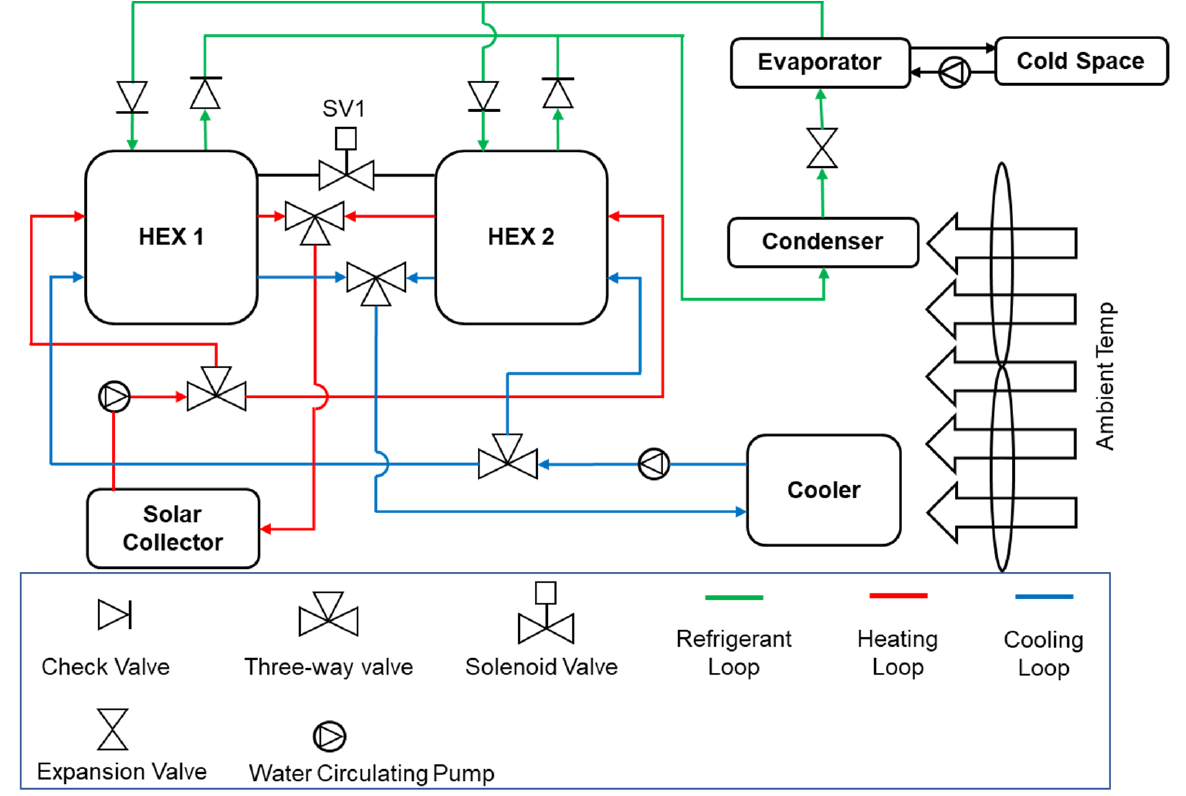
Figure 1. Layout of a two ‐ bed adsorption air conditioning system [10}.